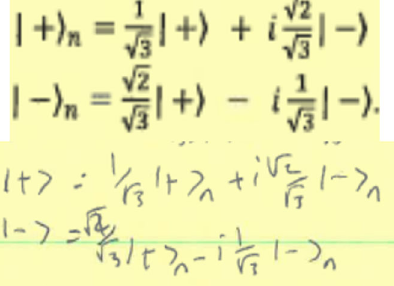
FIG. 8. An image of the given basis states (top) and a student incorrectly determining the z -basis representation by swapping subscripts (bottom). The student then substitutes these into the given state to change